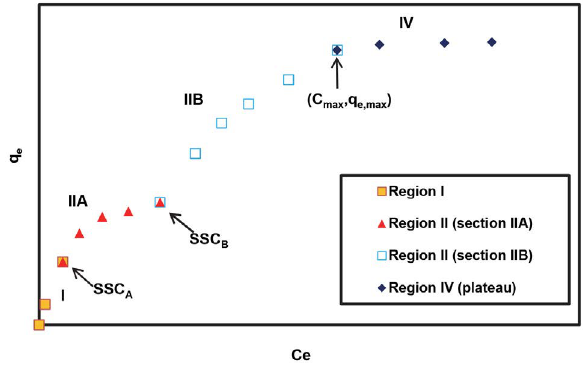
Figure 5. Typical adsorption isotherms of CR on Mg-Al-LDH na- nocompound. Different regions according to the ARIAN model are shown in the diagram.